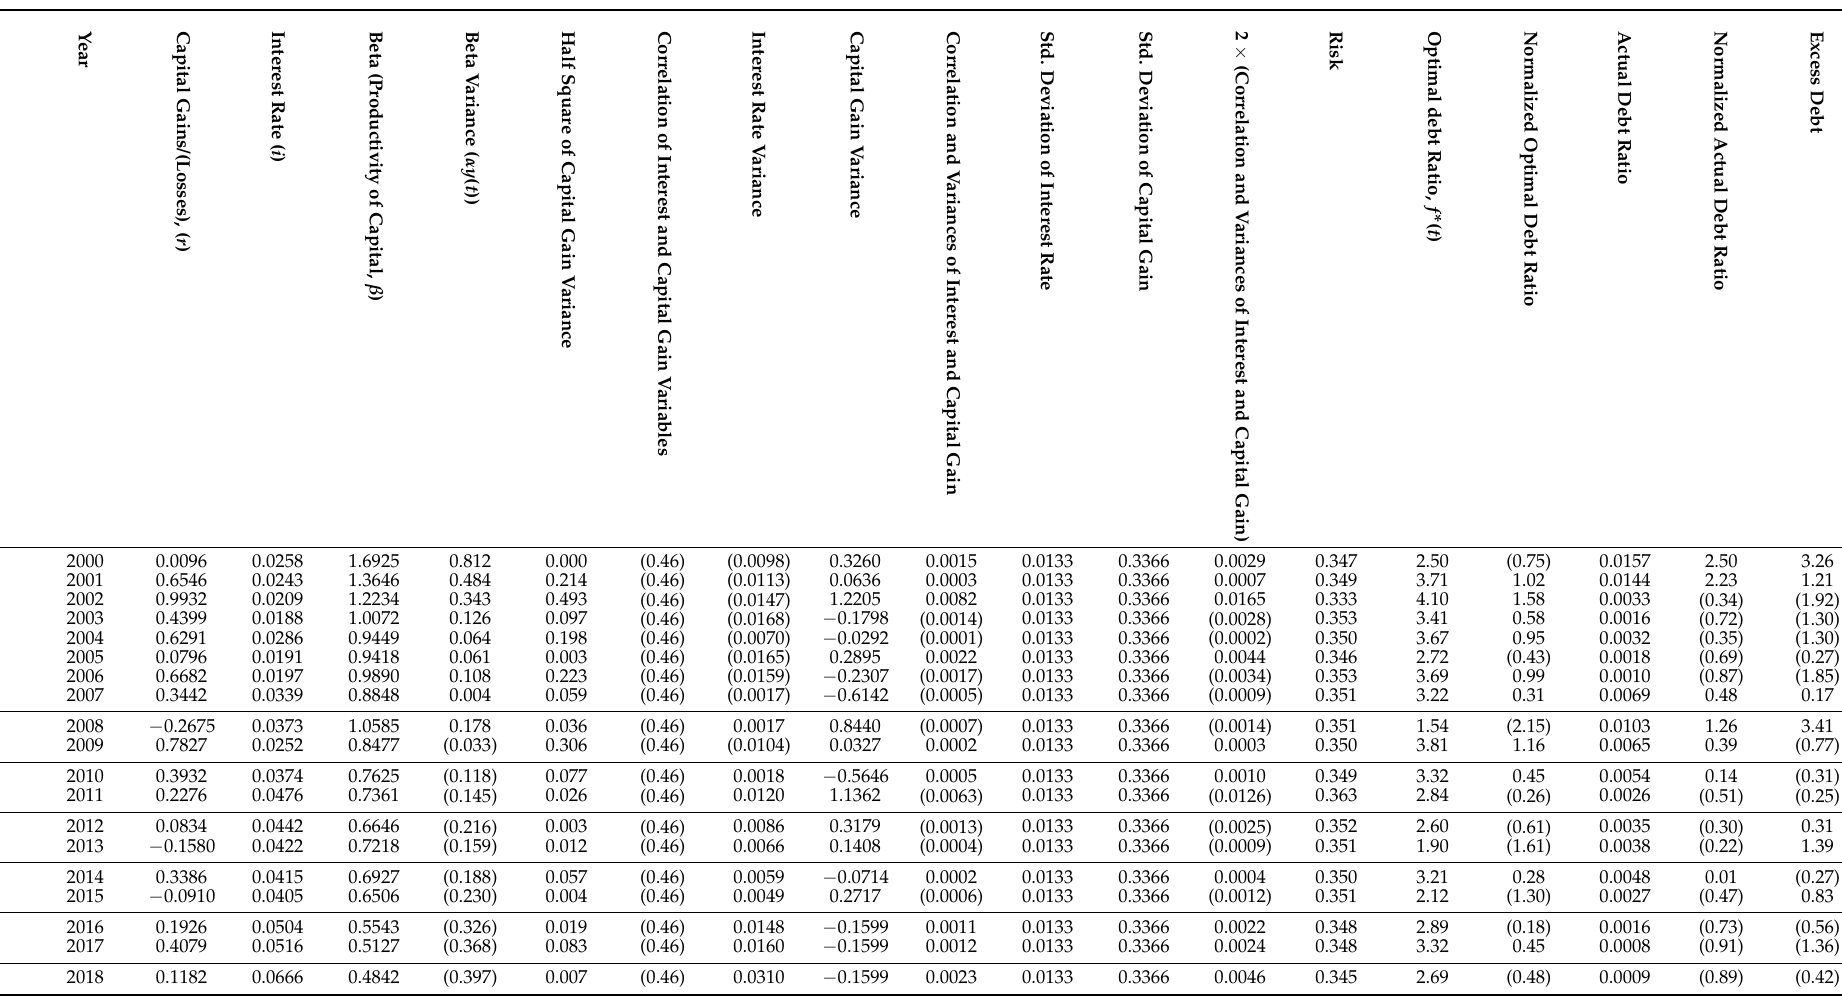
Table A6. Calculations of Optimal and Excess Debt: Bank Central